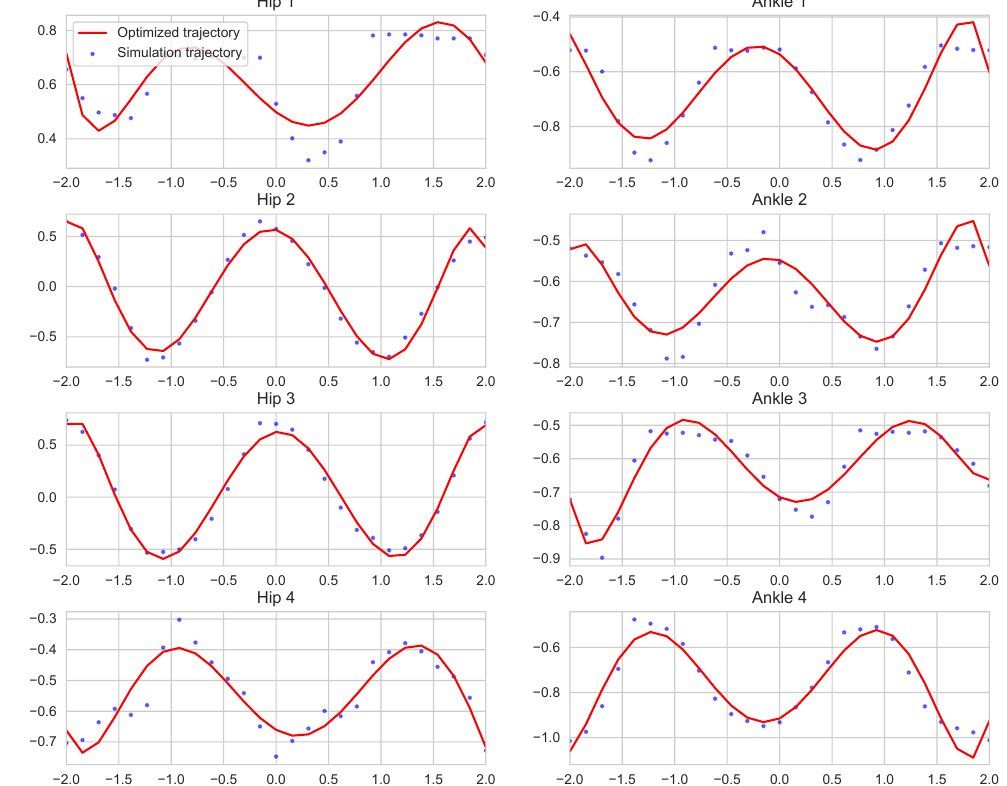
Figure 4. The blue dots are the angle trajectories of eight joints over time (s) on a simulation. The red lines are the trajectories acquired from the optimization, and each loop takes 4 s. Simulated trajectories have a larger variance, while the optimized ones are smoother, which leads to a higher energy efficiency on the real robot. We later compare this smoothness with sinusoidal